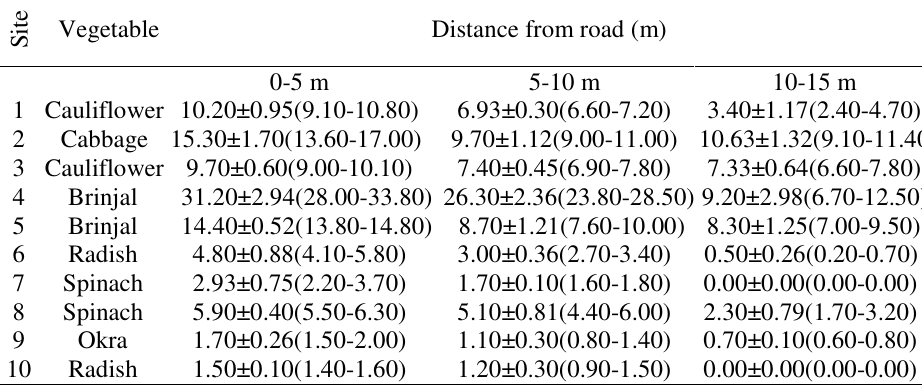
Table 3. Lead (mg/kg) in vegetable leaves at selected